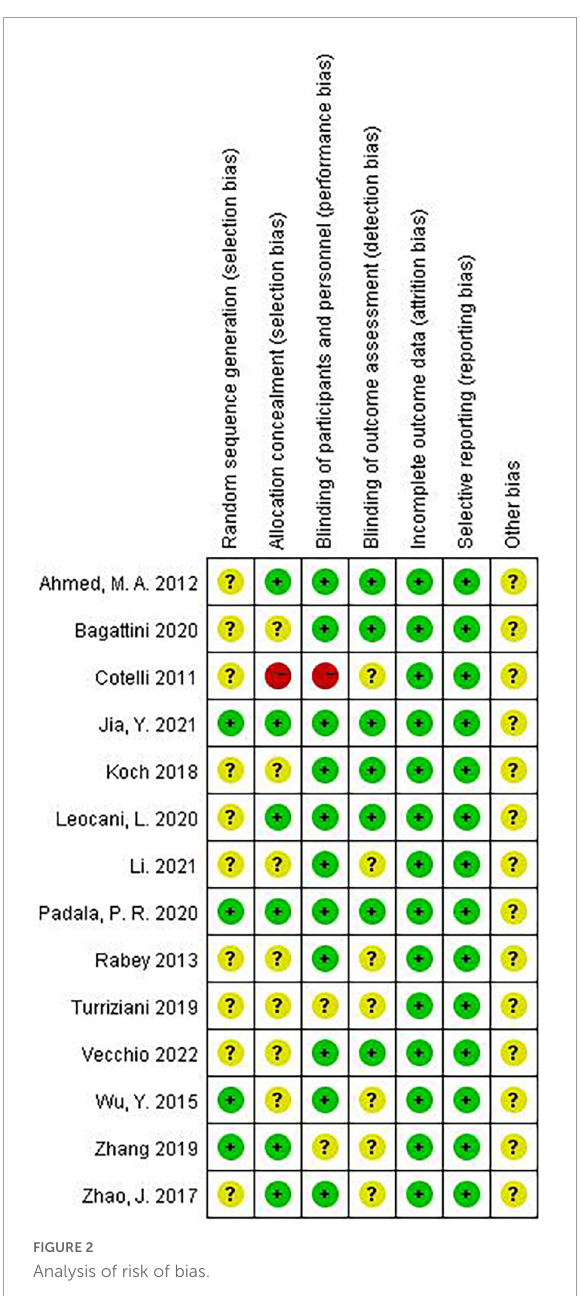
FIGURE2 Analysis of risk of